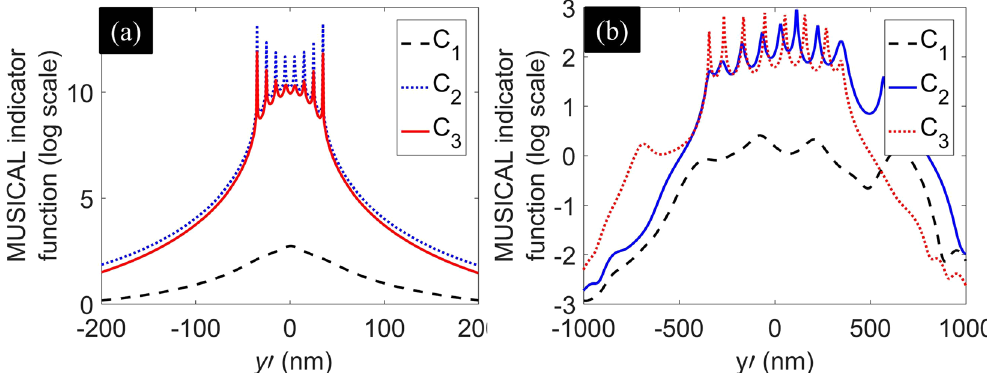
Figure 6. MUSICAL images using only C 1 , C 2 or C 3 for one-dimensional example of 8 emitters separated by 10 nm ( a ) and 100 nm ( b ). ( b ) Corresponds to Poisson noise with SNR 20. It is evident that C 1 is incapable of supporting resolution whereas C 2 and C 3 can support super-resolution, subject to noise.